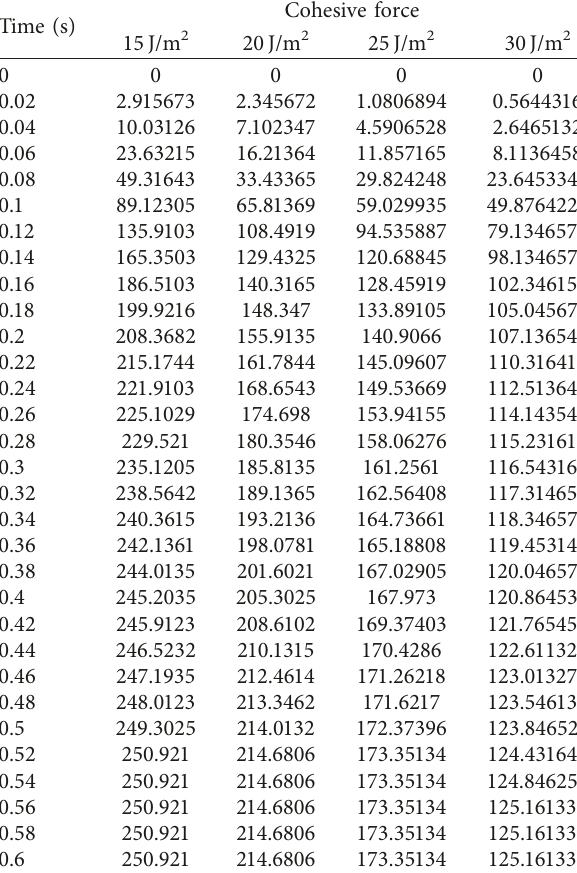
Table 2: Mass losses under different cohesive forces (g).